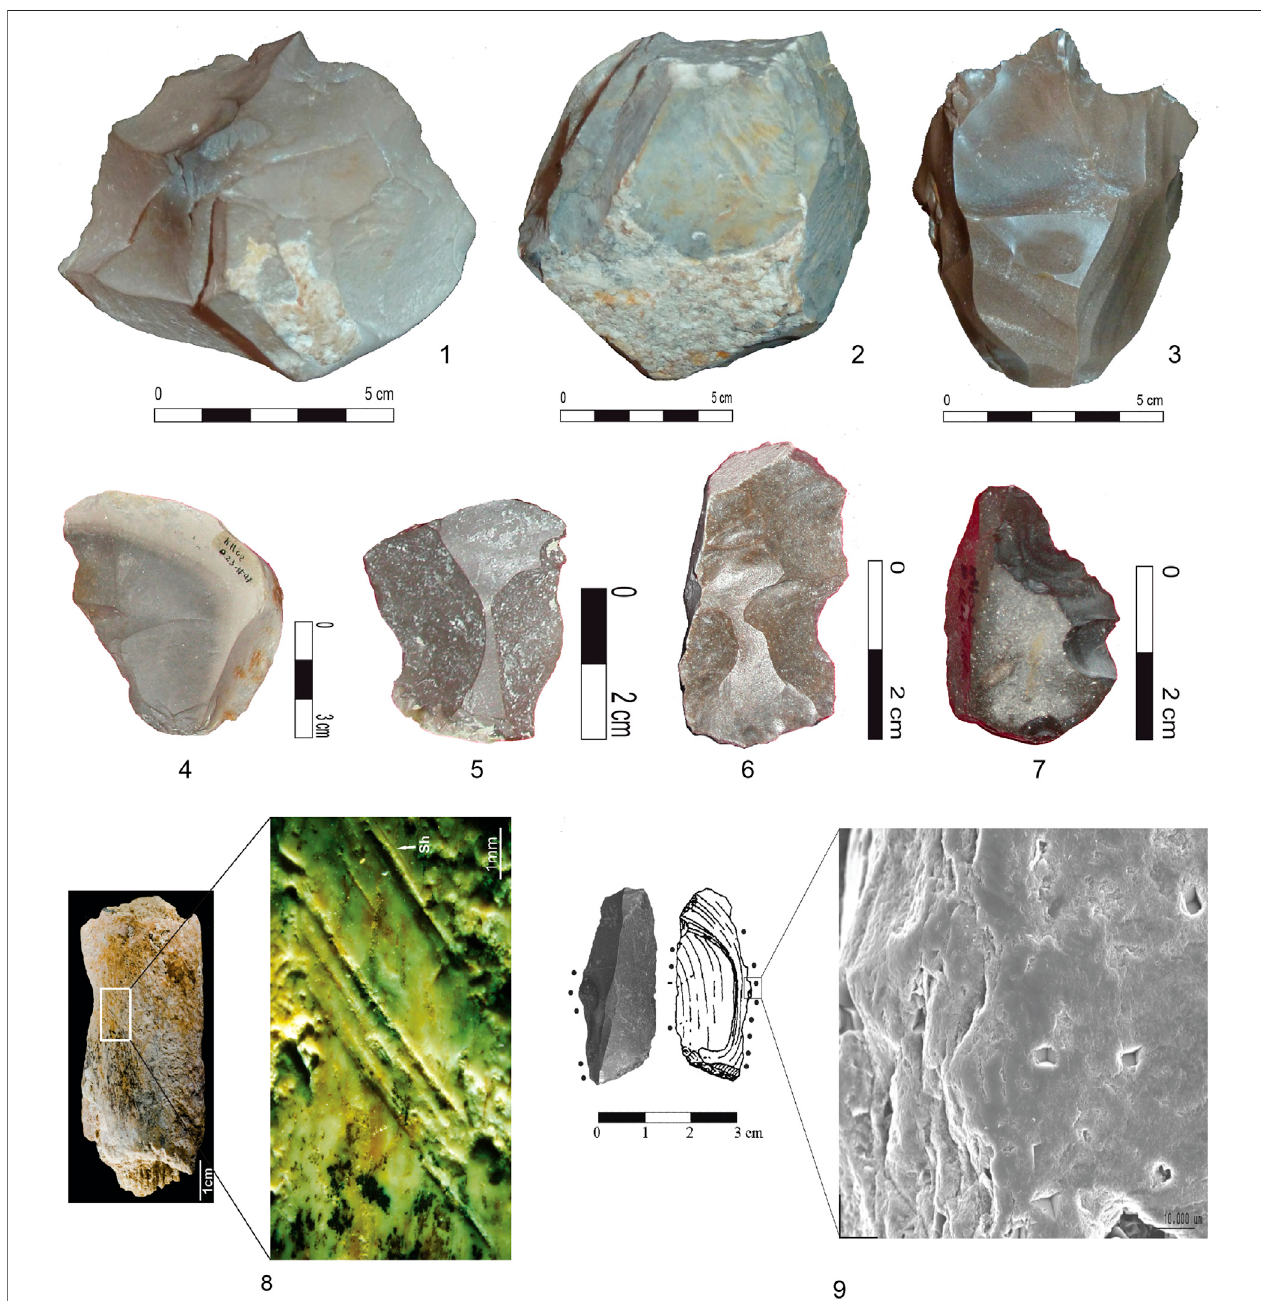
FIGURE 2 | Oldowan stone tools made of limestone and fl int and an associated fossil bone from the Early Pleistocene site of El Kherba (Algeria), including (1) a bifacialchopper,(2)apolyhedron/core,(3)acore,(4 – 6)whole fl akes,(7)adenticulate-likeretouchedpiece,(8)ahippopotamuscut-markedribfragment,and(9)awhole fl ake with evidence of usewear in cutting